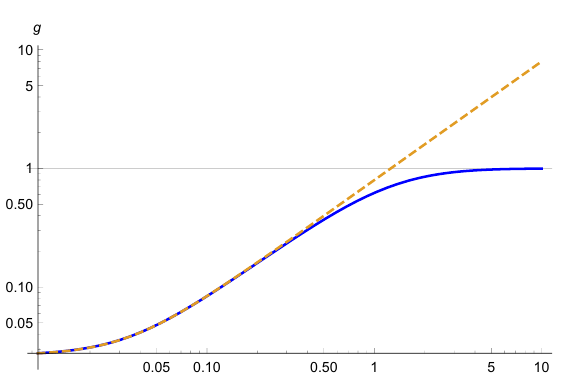
Figure 2 . Plot of the spectral form factor for ~ = (cid:21) = 1 = 30. The orange dashed curve is the genus-zero result while the blue solid curve is the plot of error